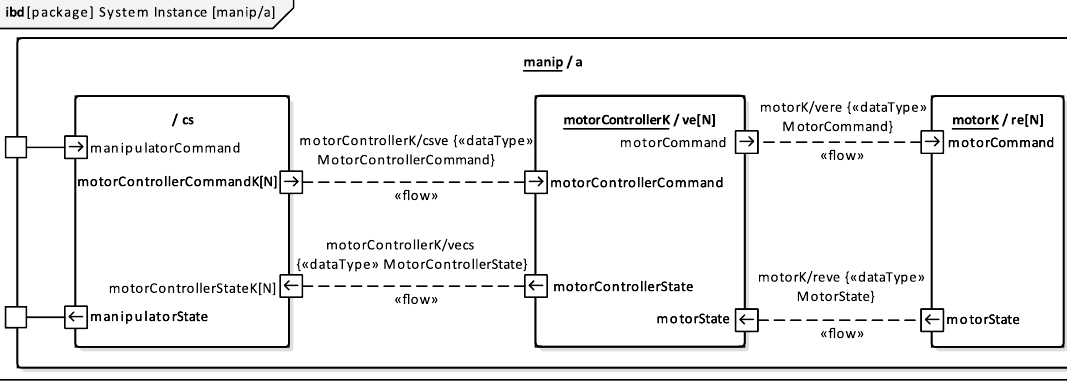
Figure 10. Structure of the Agent manip / a ; letter K placed at the end of the instance name should be substituted by a number, i.e. K ∈ { 1,..., N }